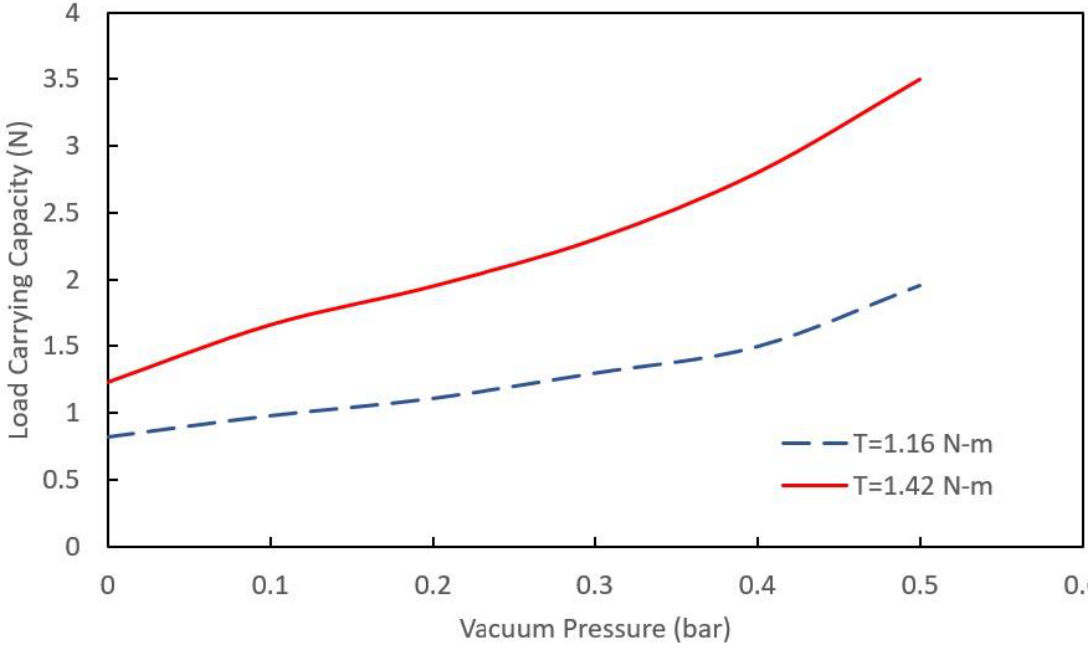
Figure 5. The load-carrying capacity of the two-finger hand as a function of vacuum pressure and applied torque, where the area under each curve constitutes the condition of stable grasping for this specific torque.